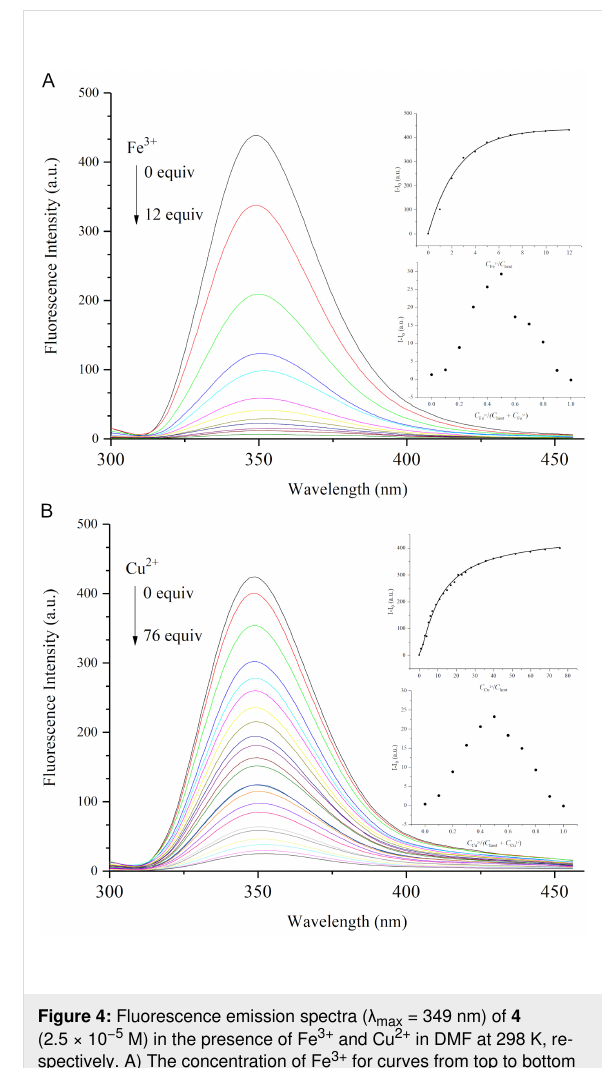
Figure 4: Fluorescence emission spectra ( λ max = 349 nm) of 4 (2.5 × 10 − 5 M) in the presence of Fe 3+ and Cu 2+ in DMF at 298 K, re- spectively. A) The concentration of Fe 3+ for curves from top to bottom were 0.0, 2.5, 5.0, 7.5, 10.0, 12.5, 15.0, 17.5, 20.0, 22.5, 25.0, 27.5 (× 10 − 5 M) with increasing Fe 3+ concentration. B) The concentration of Cu 2+ for curves from top to bottom were 0.0, 10.0, 20.0, 30.0, 40.0, 50.0, 60.0, …, 190.0 (× 10 − 5 M) with increasing Cu 2+ concentration. Insets: The inset on top is the nonlinear fitting curve of the fluores- cence intensity I − I 0 with increasing Fe 3+ or Cu 2+ concentration. The bottom inset is the Job’s plot for the 4 –Fe 3+ or 4 –Cu 2+ complex in DMF solution. ([4] + [Fe 3+ ] = 2.5 × 10 − 5 M, [4] + [Cu 2+ ] = 2.5 × 10 − 5